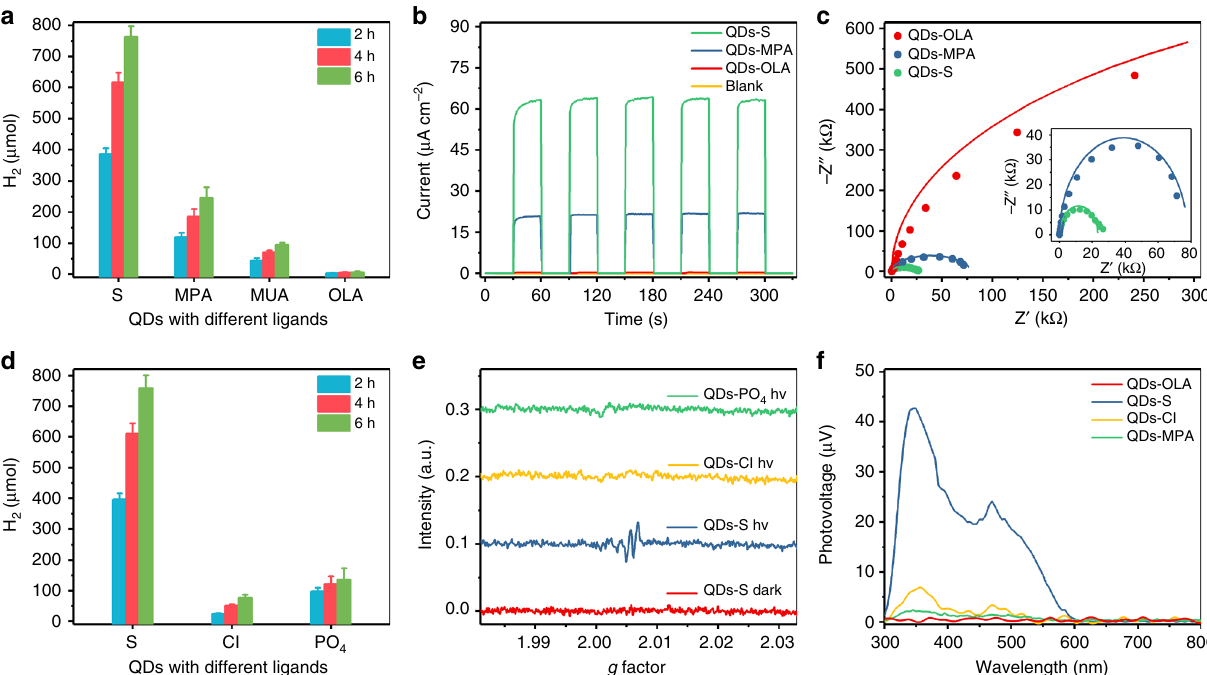
Fig. 5 In fl uence of different ligands on the hydrogen evolution performance and photophysical properties of InP/ZnS QDs (525 nm, 15 min). a Hydrogen evolution for InP/ZnS QDs capped with different organic ligands. Conditions: 1.6 μ M QDs and 0.035 mM Ni 2 + in 6 mL of 0.2 M H 2 A (pH 4.5) were illuminated with a LED light source (525 nm, 4 × 1 W). b Transient photocurrent and c electrochemical impedance spectra of InP/ZnS QDs with different ligands at open circuit voltage under simulated sunlight illumination. Conditions: electrolyte: 0.2 M H 2 A, pH 4.5; frequency range: 0.1 – 10 5 Hz. d Hydrogen evolution for InP/ZnS QDs capped with different inorganic ligands. Conditions: 1.6 μ M QDs and 0.035 mM Ni 2 + in 6 mL of 0.2 M H 2 A (pH 4.5) were illuminated with a LED light source (525 nm, 4 × 1 W). e EPR spectra for InP/ZnS QDs with different ligands. The magnetic fi eld intensity was transformed into g factor values. f SPV spectra for InP/ZnS QDs capped with different ligands. Xe lamp was used for irradiation. Error bars were estimated based on the standard deviation according to three independent